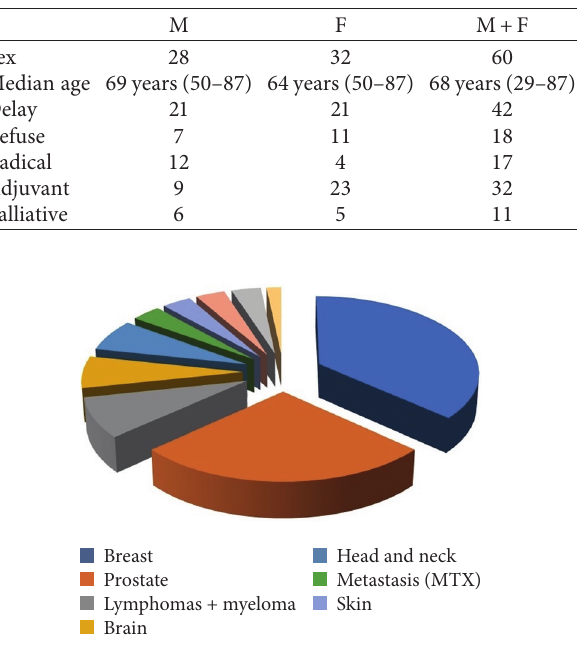
Figure 1: Diagnosis